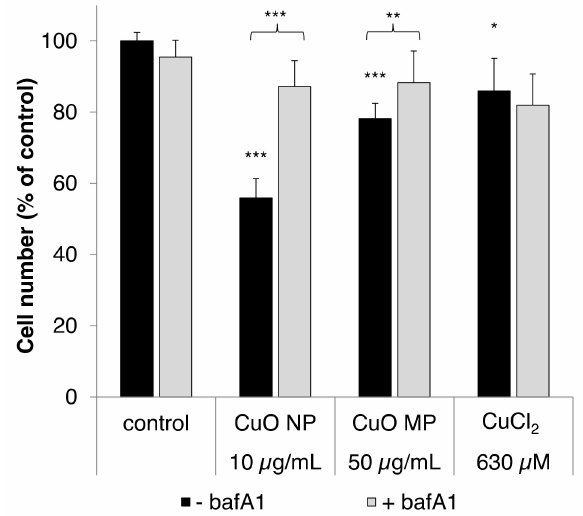
Figure 1. Cytotoxicity of copper oxide nanoparticles (CuO NP), copper oxide microparticles (CuO MP) and CuCl 2 in the absence or presence of bafA1. Cytotoxicity was determined via cell number after 24 h treatment, with the di ff erent copper compounds co-treated with or without bafA1, respectively. Shown are mean values of five determinations derived from three independent experiments + standard deviation (SD). Statistically significant di ff erent from control or the respective copper compound treatment: * p ≤ 0.05, ** p ≤ 0.01, *** p ≤ 0.001 (T-test). Based on the copper content, 50 µ g / mL CuO are equal to 630 µ M Cu 2 +